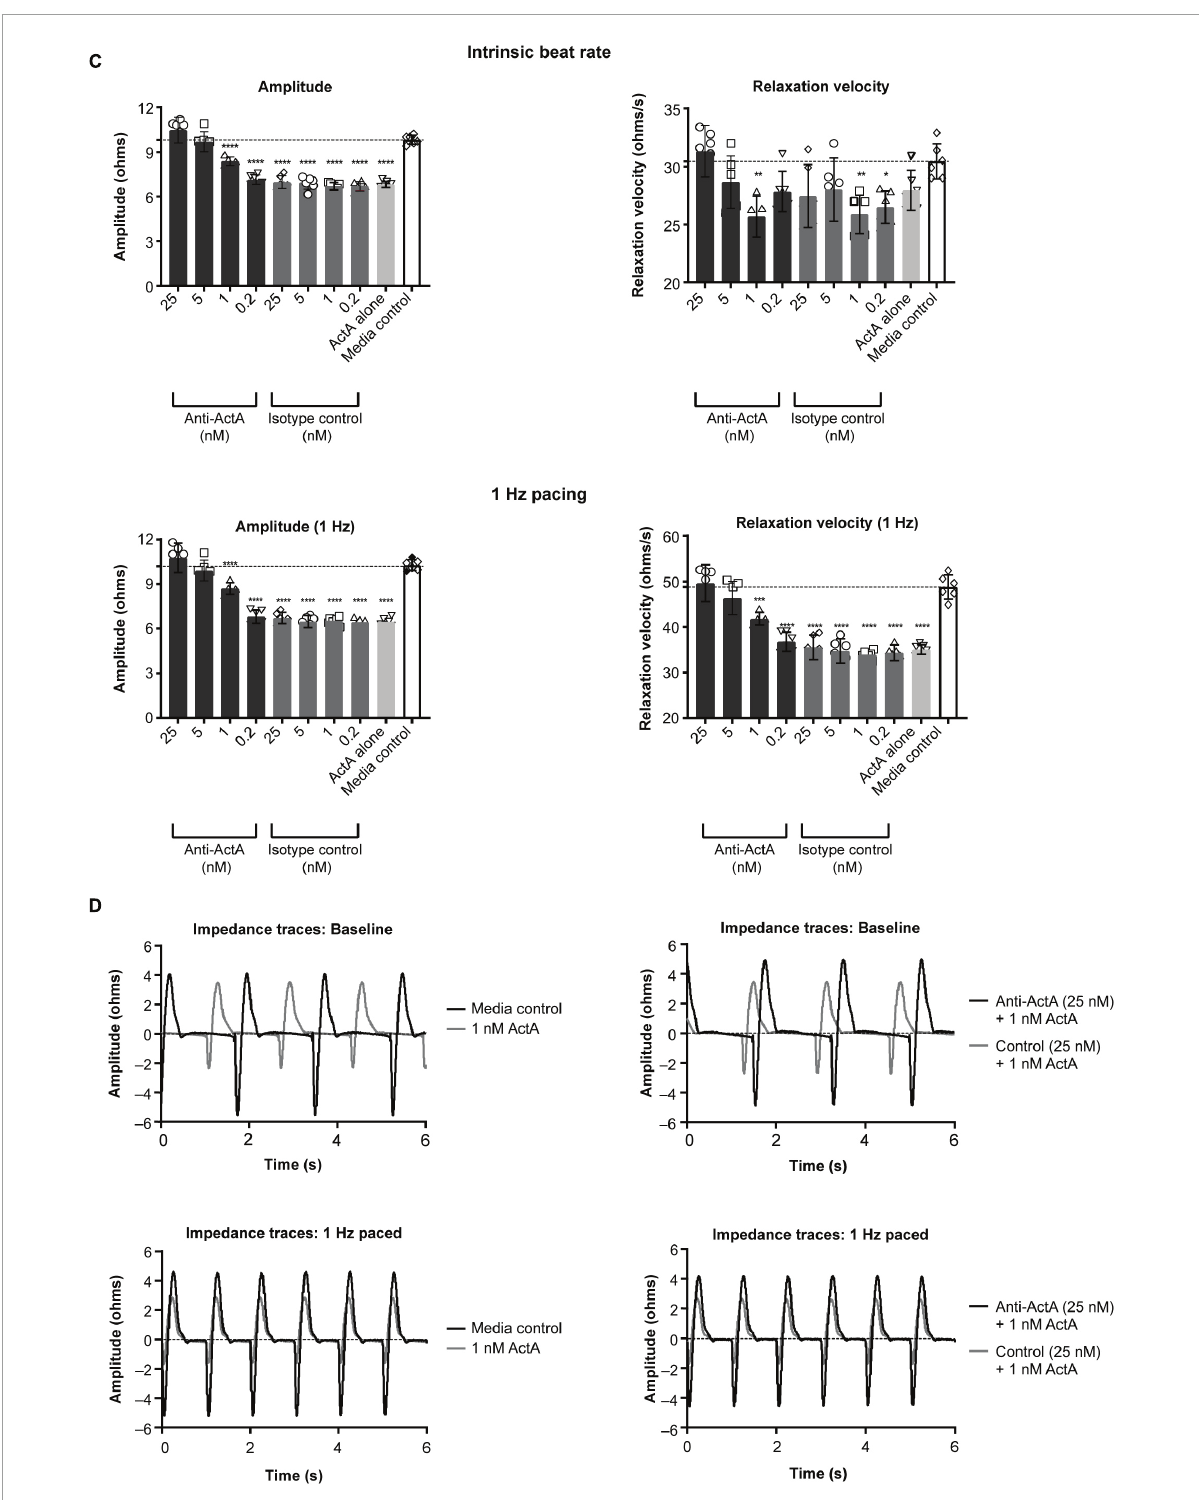
FIGURE3 Activin A exposure time course on hiPSC-CM function. (A) The effect of different concentrations of Activin A on hiPSC-CM contractile impedance amplitude. (B,C) The impact of Activin A inhibition on Activin A–induced contractile dysfunction in hiPSC-CMs: dose-dependent effect on contractile impedance amplitude (B) and contractile parameters at both intrinsic and normalized beat rate (C) . (D) Representative traces at both intrinsic beat rate and paced at 1 Hz hiPSC-CM, induced pluripotent stem cell-derived CM. Vertical lines indicate media changes in panels (A,B) . One-way ANOVA was used to determine significance. * P < 0.05, ** P < 0.01, *** P < 0.001, **** P < 0.0001. ActA, Activin A; CM, cardiomyocyte; hiPSC-CM, human-induced pluripotent stem cell-derived